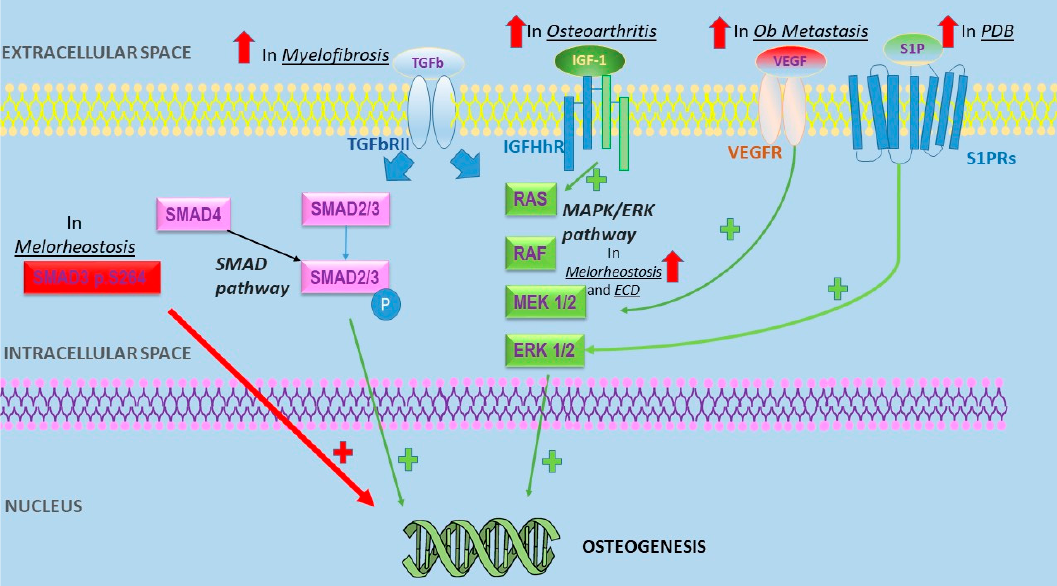
Figure 1. Schematic representation of several altered intracellular mechanisms in Ob underlying the etiopathogenesis of osteosclerosis in various non-hereditary sclerosing bone diseases. Abbreviations: PDB: Paget’s disease of the bone; ECD: Erdheim-Chester Disease; Ob: osteoblast.